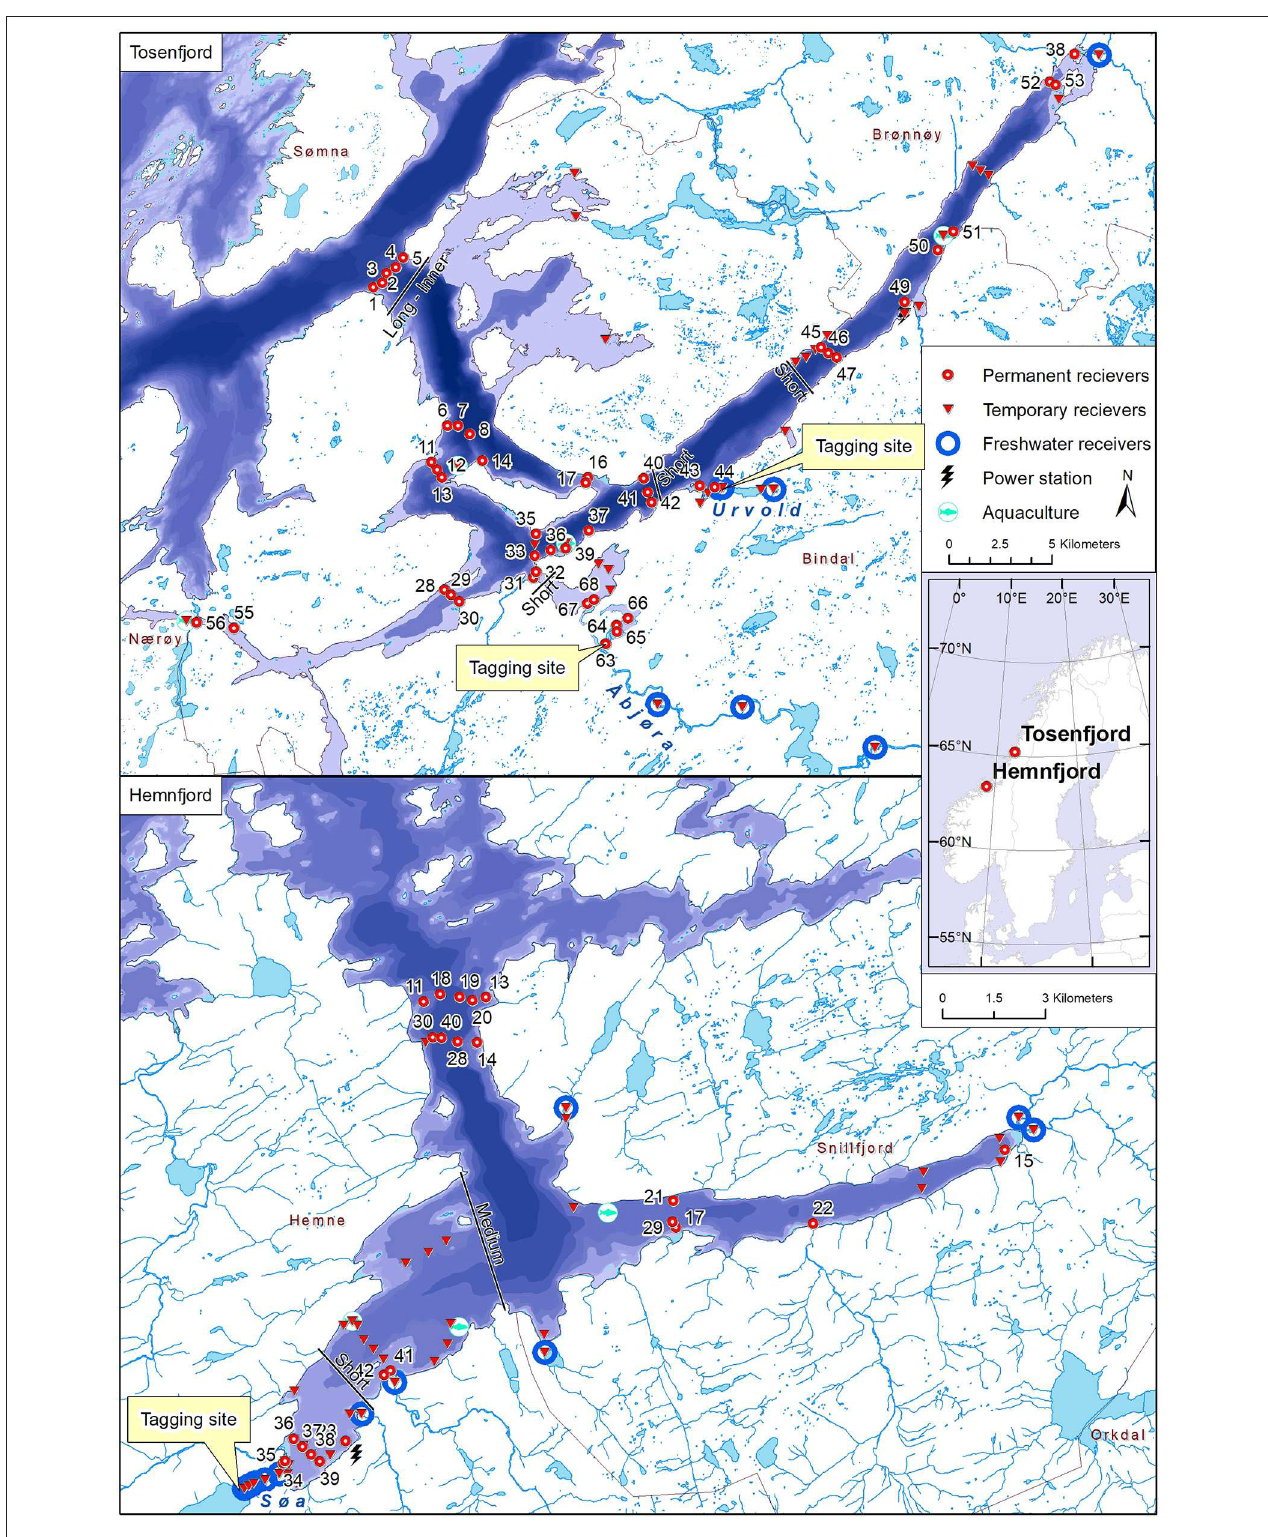
FIGURE 1 | Map over study site Tosenfjord (upper) and Hemnfjord (lower), with site of tagging and locations of deployed receivers. Short-, medium-, and long-inner lines indicate the defined boundaries used to classify migratory behavior based on minimum travel distance. Two-digit numbers indicate receiver ID’s included in the network